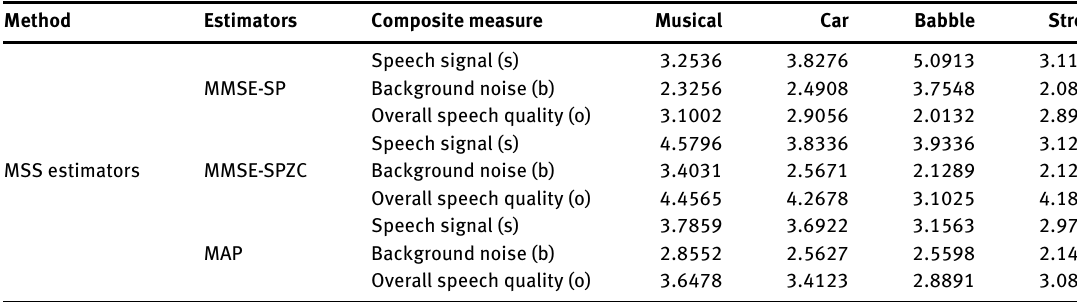
Table 8: Performance Evaluation of MSS Estimators Using Composite Measure for TIMIT Database.